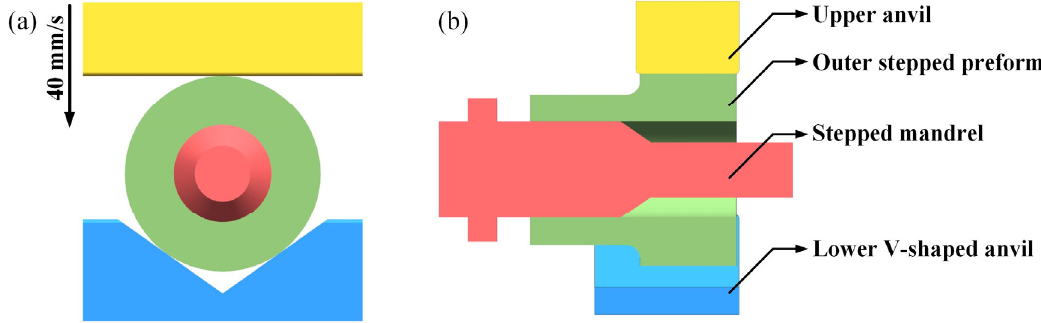
Figure 4. Numerical model for the MFN process: ( a ) front view; ( b ) right-side view.